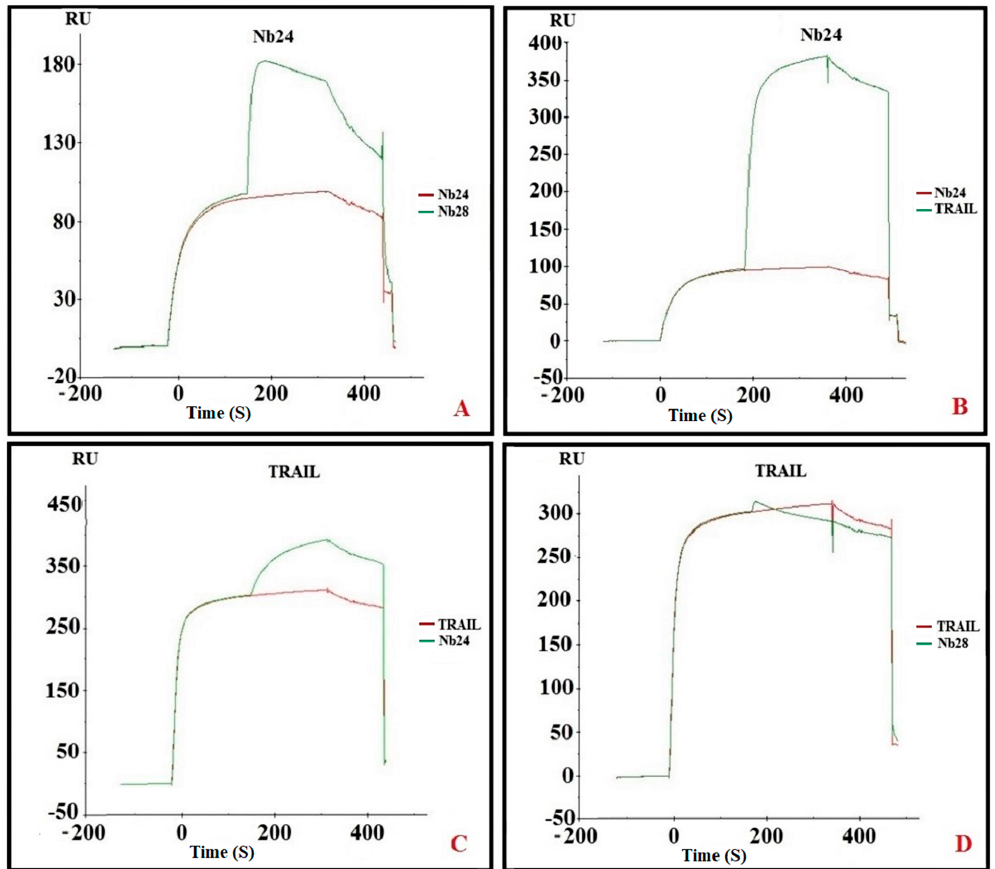
Figure 3. Sensorgrams used for epitope binning. ( A ) SPR sensorgram where DR5 is first saturated with Nb24 followed by Nb24 (red curve) or a mixture of Nb24 and Nb28 (green curve). ( B ) SPR sensorgram where DR5 is first saturated with Nb24 and subsequently with Nb24 (red curve) or a mixture of Nb24 plus tumor necrosis factor–related apoptosis-inducing ligand (TRAIL). ( C , D ) SPR sensorgram where DR5 is first saturated with TRAIL and thereafter with TRAIL alone (red curves) or with a mixture of TRAIL and Nb24 (green curve in C) or TRAIL and Nb28 (green curve in